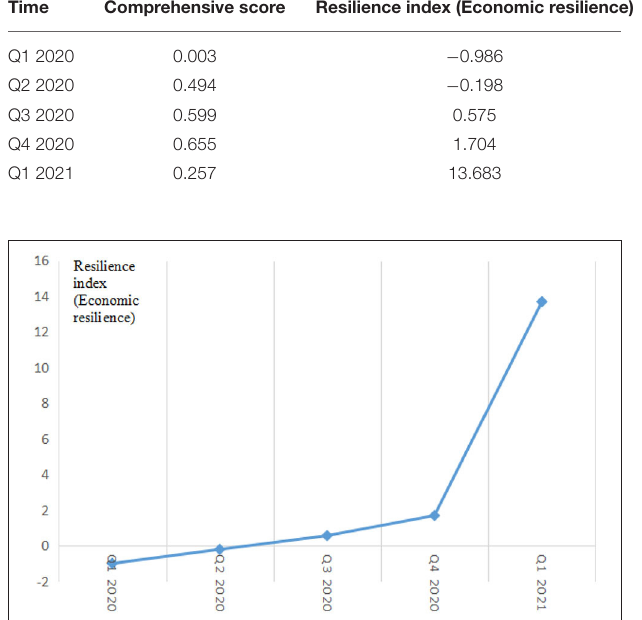
FIGURE 2 | Line chart of China’s macroeconomic resilience index from the first quarter of 2020 to the first quarter of 2021.